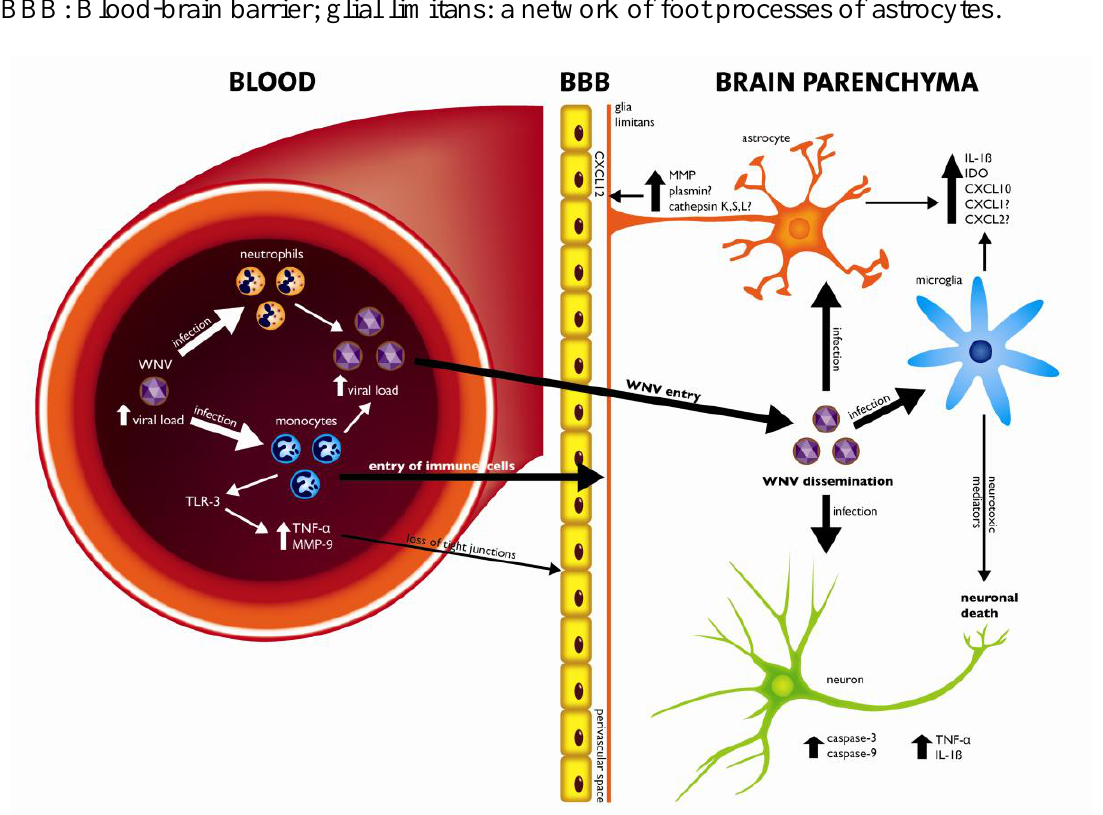
Figure 2. Regulation of Blood-brain barrier permeability, entry of WNV in the brain and factors involved in the pathogenesis of WNV-induced neuroinvasisve disease. Following inoculation of WNV in the dermis, virus infects and replicates in cells of the mononuclear lineage and neutrophils. Monocytes and neutrophils act as reservoirs for viral replication and dissemination, resulting in an increase in viral load. Recognition of WNV replication by TLR3 in monocytes leads to production of TNF-α and MMP-9 in a dose-dependent manner, resulting in loss of tight junctions, which allows entry of WNV and immune cells into the brain. High viral loads facilitate entry and dissemination of WNV into the brain. Expression of CXCL12 plays an important role in the retention of immune cells in the perivascular spaces of the CNS. Production of MMPs, cathepsins and plasmin by activated/infected monocytes and glial cells are probably involved in migration of cells from the perivascular space into the brain parenchyma. Furthermore, infected glial cells and neurons release neurotoxic mediators, leading to neuronal death. Neuronal death is mediated for a great part via the caspase-9 and caspase-3 pathway, which is dependent on the capsid of WNV. WNV: West Nile virus; TNF-α: Tumor necrosis factor-α; MMP: Matrix metalloproteinases; TLR: Toll-like receptor; CXCL: chemokine; IL: Interleukin; BBB: Blood-brain barrier; glial limitans: a network of foot processes of